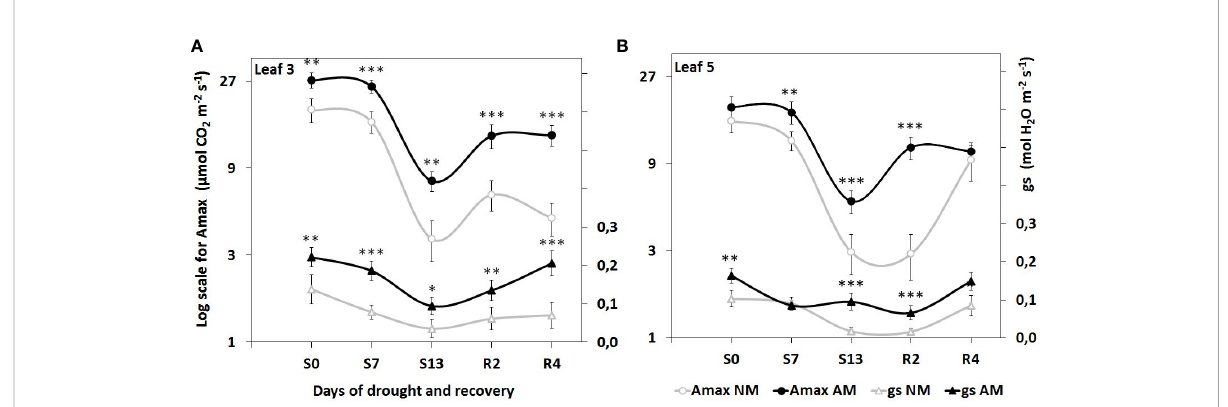
FIGURE 2 Evaluation of light-saturated leaf gas exchange ef fi ciency in (A) apical (L3) and (B) middle (L5) leaves, at subsequent time points of drought development (S0-S13) and rehydration (R2, R4), in relation to the presence (AM) or the absence (NM) of mycorrhiza. Amax: light-saturated CO 2 assimilation rate, gs: maximum stomatal conductance to H 2 O. Points represent mean values and standard deviation. Statistically signi fi cant differences between AM and NM means (n=6), calculated using Students t -test are presented with asterisks (* p <0.05, ** p <0.01, *** p